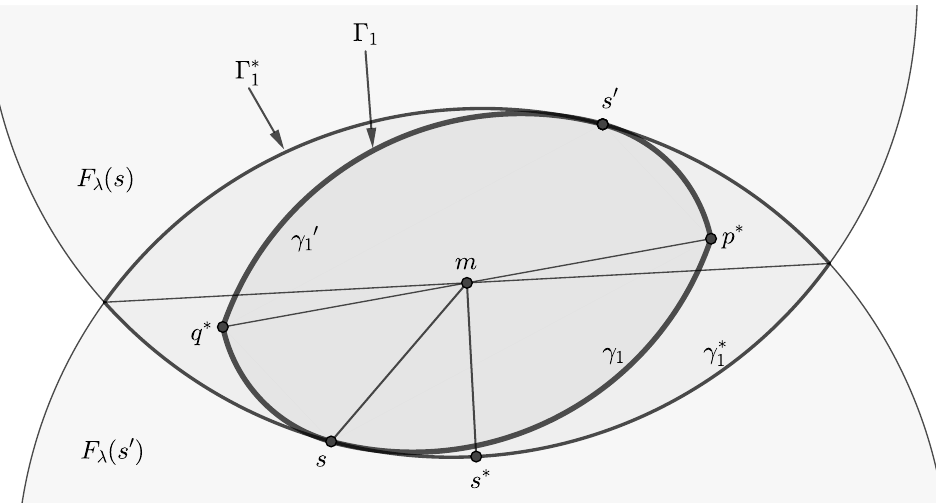
Figure 1: The construction in the proof of Theorem 1.1 for the case when the ambient metric space is one of the constant cur- vature spaces. The subarc γ 1 of the curve γ cut by the geodesic p * q * given by Lemma 2.1. The curve γ (cid:48) point reflection of γ 1 in m , where m is the midpoint of the geodesic segment p * q * . The convex region bounded by the